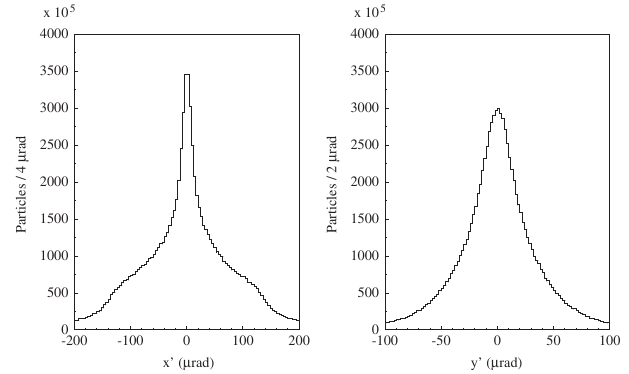
FIG. 3. Horizontal and vertical angular distributions of the beamstrahlung photons, obtained with GUINEA-PIG using Gaussian incoming beams and normalized to one bunch.